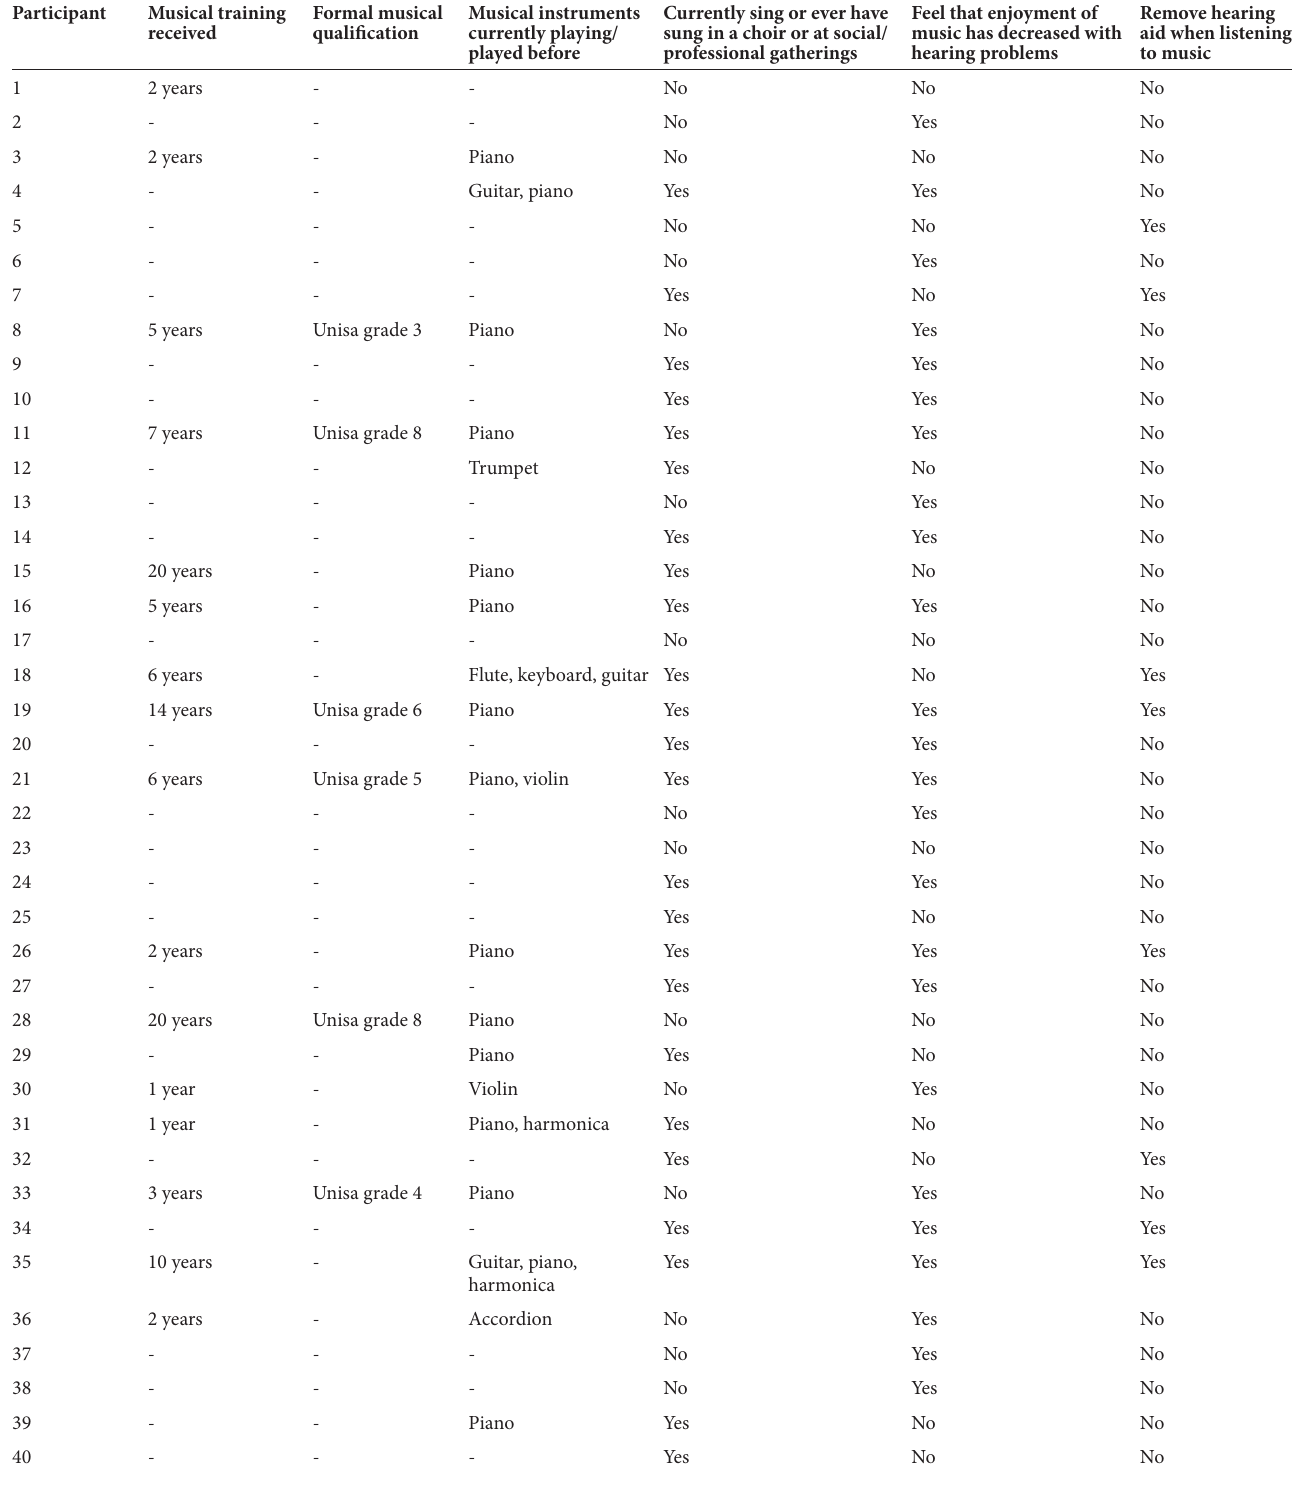
Table 2. Participants’ musical history